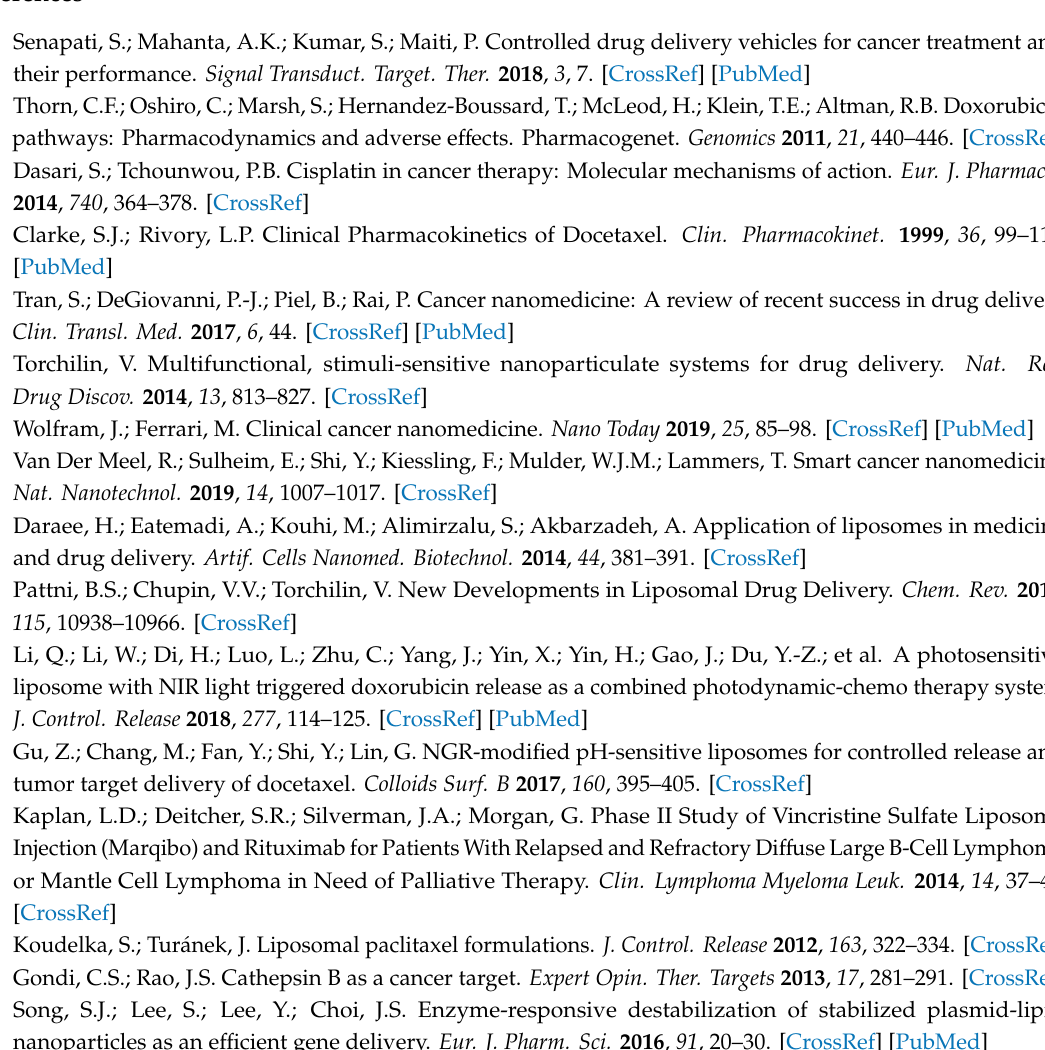
Figure S1: 13 C-NMR spectrum of PEG-GLFG in DMSO-d 6 (600MHz), Figure S2: The cytotoxicity e ff ect of GLFG liposomes at various compositions with encapsulated Dox (final 2.5 µ M) on Hep G2